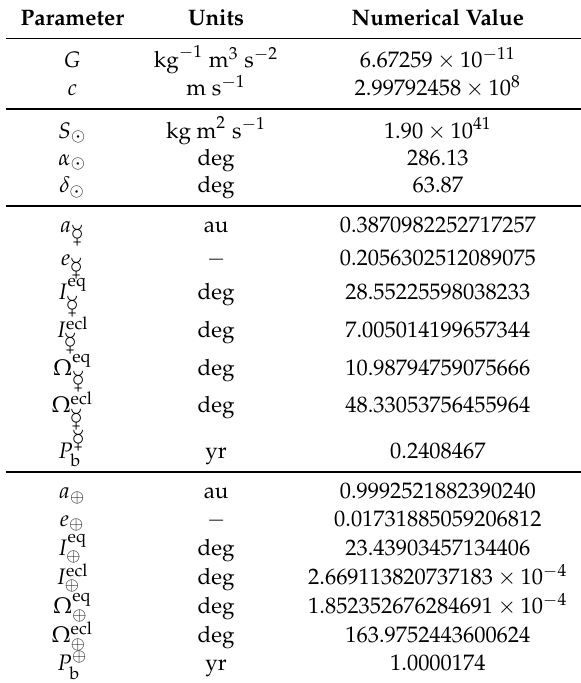
Table A2. Relevant physical and orbital parameters used in the text for the Sun, Mercury and the Earth. Most of the reported values come from Petit, Luzum & et al. [29], Seidelmann et al. [30], Soffel et al. [31] and references therein. The source for the orbital elements referred to either the mean ecliptic (ecl) at the reference epoch J2000.0 or the mean Earth’s equator (eq) at the same epoch is the freely consultable database JPL HORIZONS on the Internet at https://ssd.jpl.nasa.gov/?horizons from which they were retrieved by choosing the time of writing this paper as input